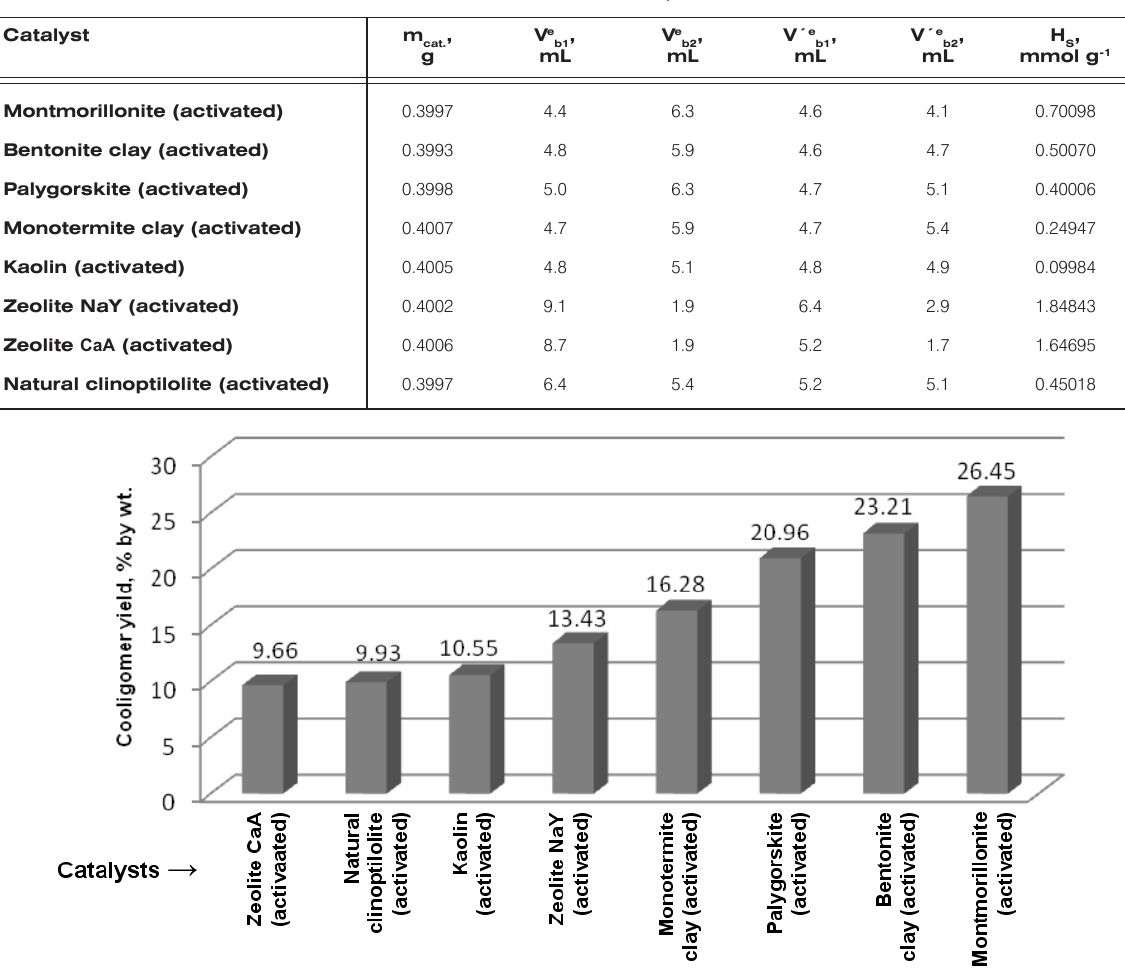
Figure 3. Cooligomer yields obtained from C